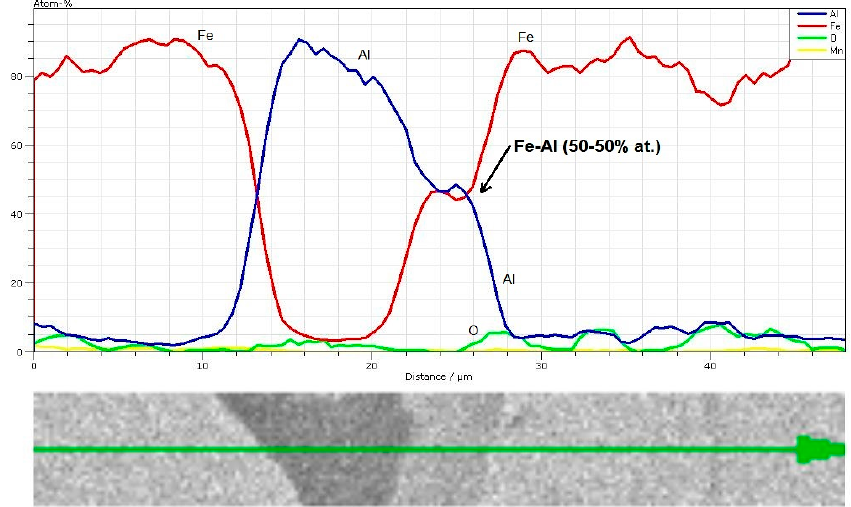
Figure 8. Linear distribution of elements in the crystal boundary, confirming the presence of the Fe-Al phase, with the composition of about 50–50% at.